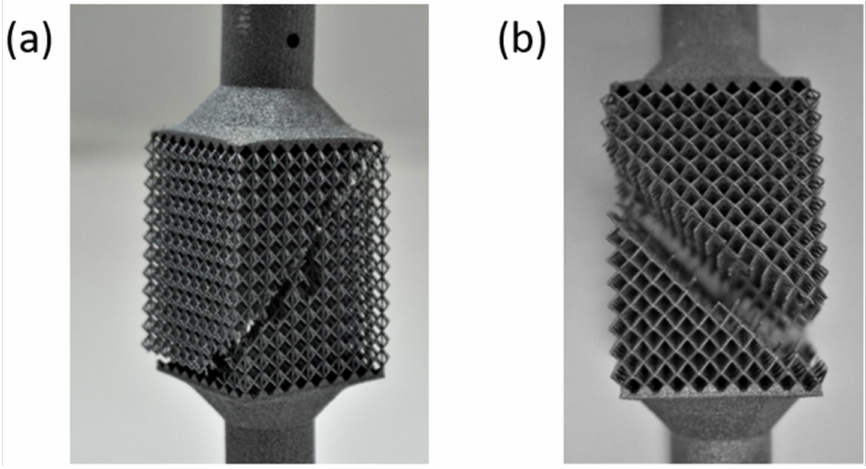
Figure 15. Failed specimen: f2ccz ( a ), bcc ( b